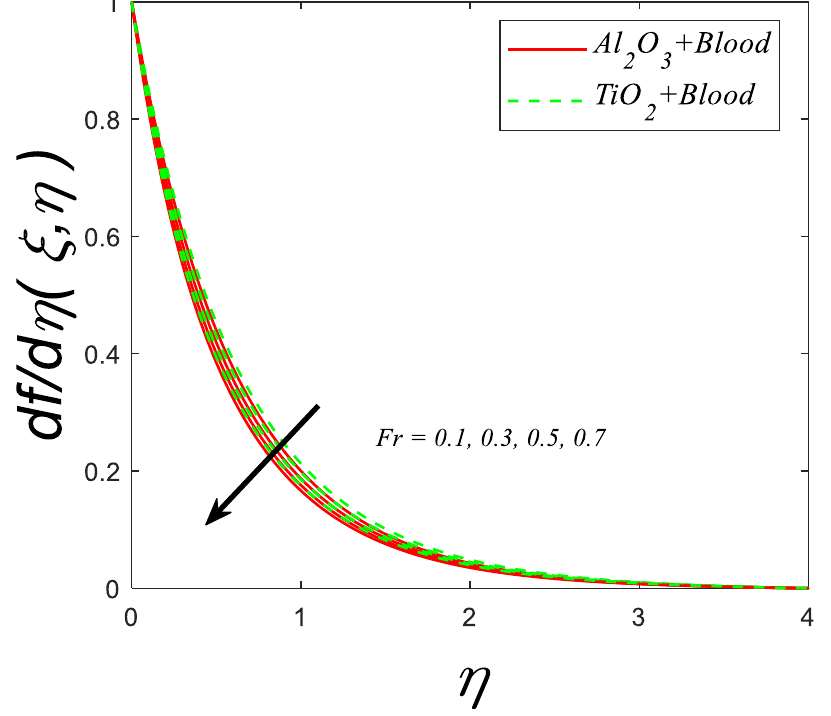
𝜋 , 𝜉 = 0.1,𝑅𝑑 = , ξ = 0.1, Rd = 0.1, 3 3